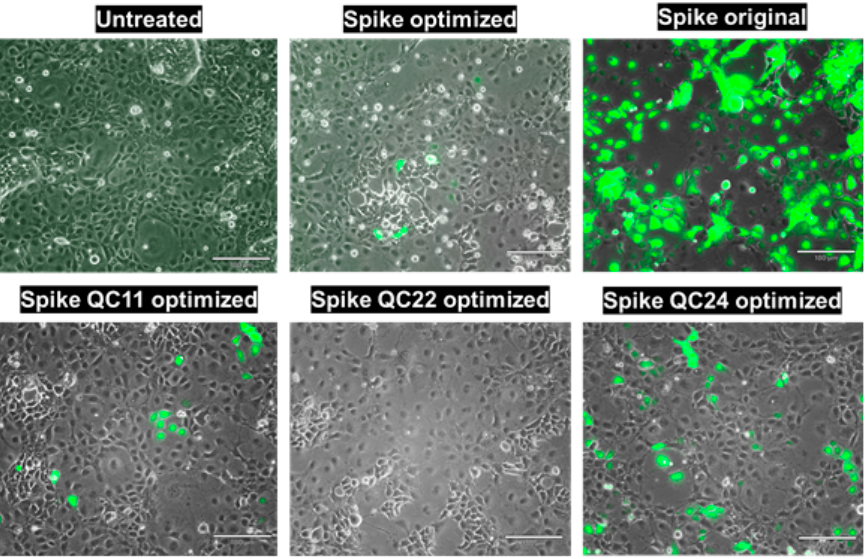
Figure 6. COS7 infection with LV-produced pseudovirions. Experiments were conducted in duplicate and repeated several times. Scale bar = 180 µ m.